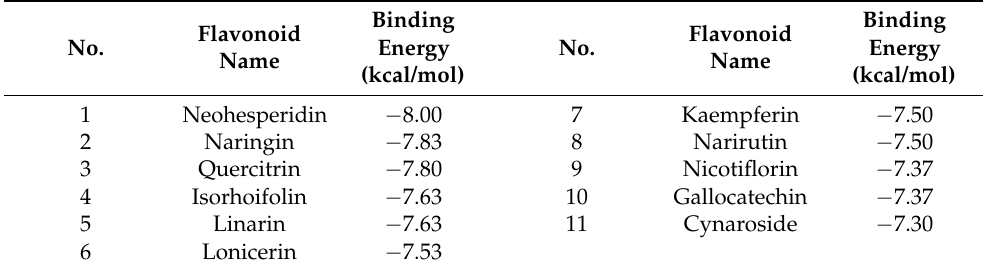
Table 6 lists five components of PCR which had lower binding energy for spike than lopinavir. Isoxaphoroside had the lowest value of − 13.33 kcal/mol. In addition, lonicerin,